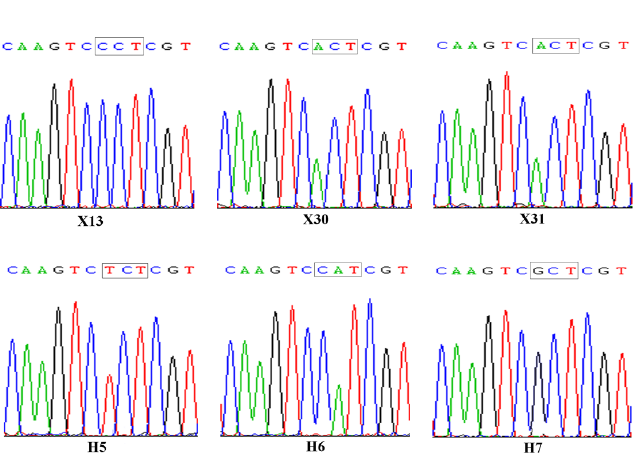
Figure 2. Dose response of high resistance D. sophia subpopulations to tribenuron-methyl.